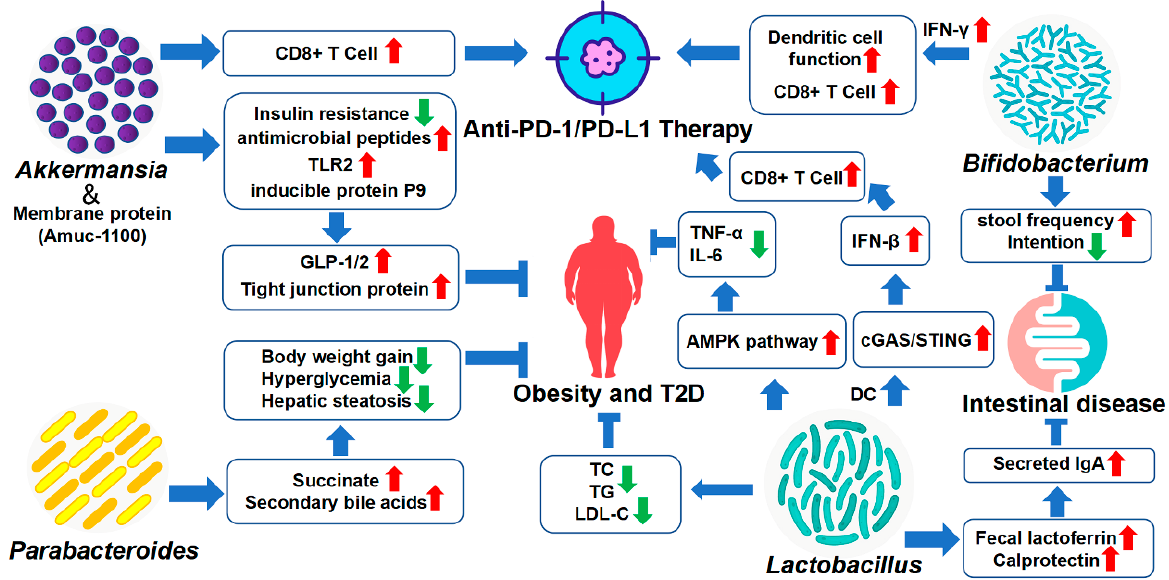
Figure 2. Therapeutic and sensitizing effects of gut microbiota on disease treatment. The application of gut microbiota in the treatment and prevention of diseases has been in use for a long time, and with the deepening of research, new probiotics have emerged. Except for the common Bifidobacterium and Lactobacillus , Akkermansia and Parabacteroides are expected to become a new generation of probiotics, with the potential to treat diseases such as obesity. What is more, Akkermansia and Bifidobacterium also show promise in sensitizing PD-1/ PD-L1 therapy. Note: Toll-like Receptors 2, TLR2; Glucagon-like Peptide-1, GLP-1; Programmed Cell Death 1, PD-1; Programmed Cell Death-Ligand 1, PD-L1; Total Cholesterol, TC; Triglyceride, TG; Low-Density Lipoprotein Cholesterol, LDL-C; Dendritic Cells, DC. The meaning of a symbol in the table: red arrow, up-regulated; green arrow,